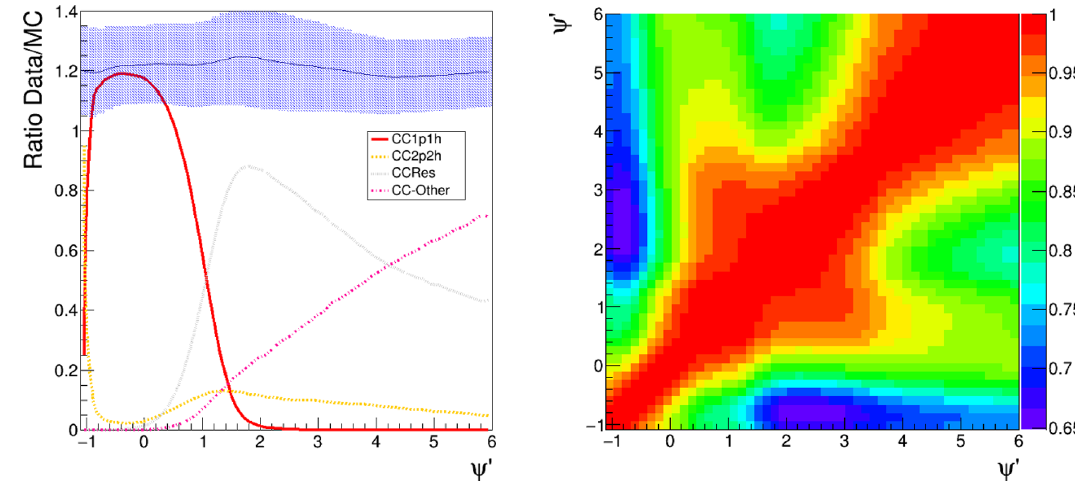
Figure 23 . The same as figure 21, but for the T2K CC inclusive cross-section.